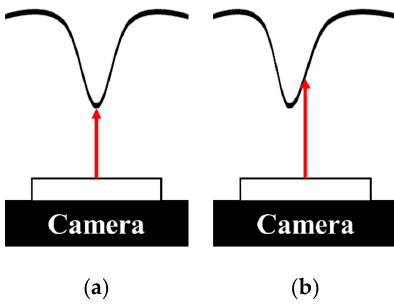
Figure 6. Correlation of contact surface change with camera sensor according to contact position ( a ) when pressing the center of the contact surface ( b ) when pressing the outer of the contact surface.